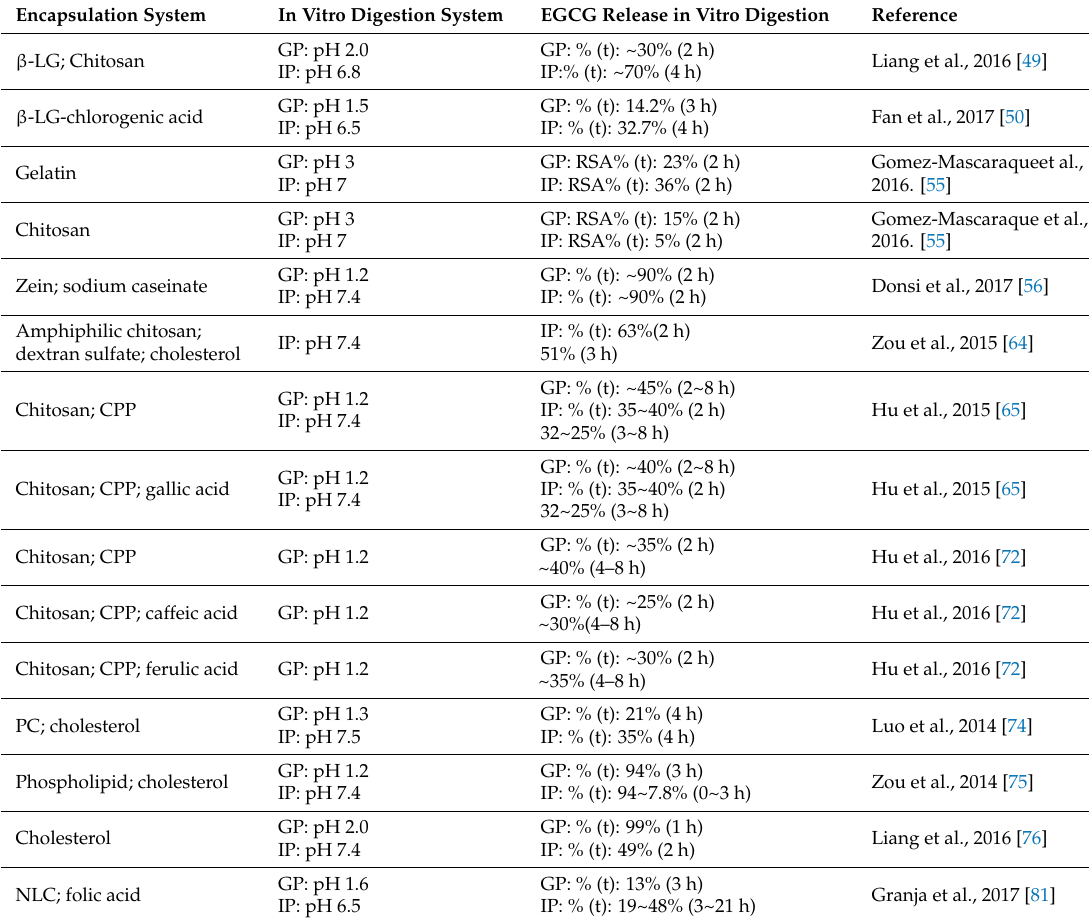
Table 4. EGCG release in vitro digestion system after